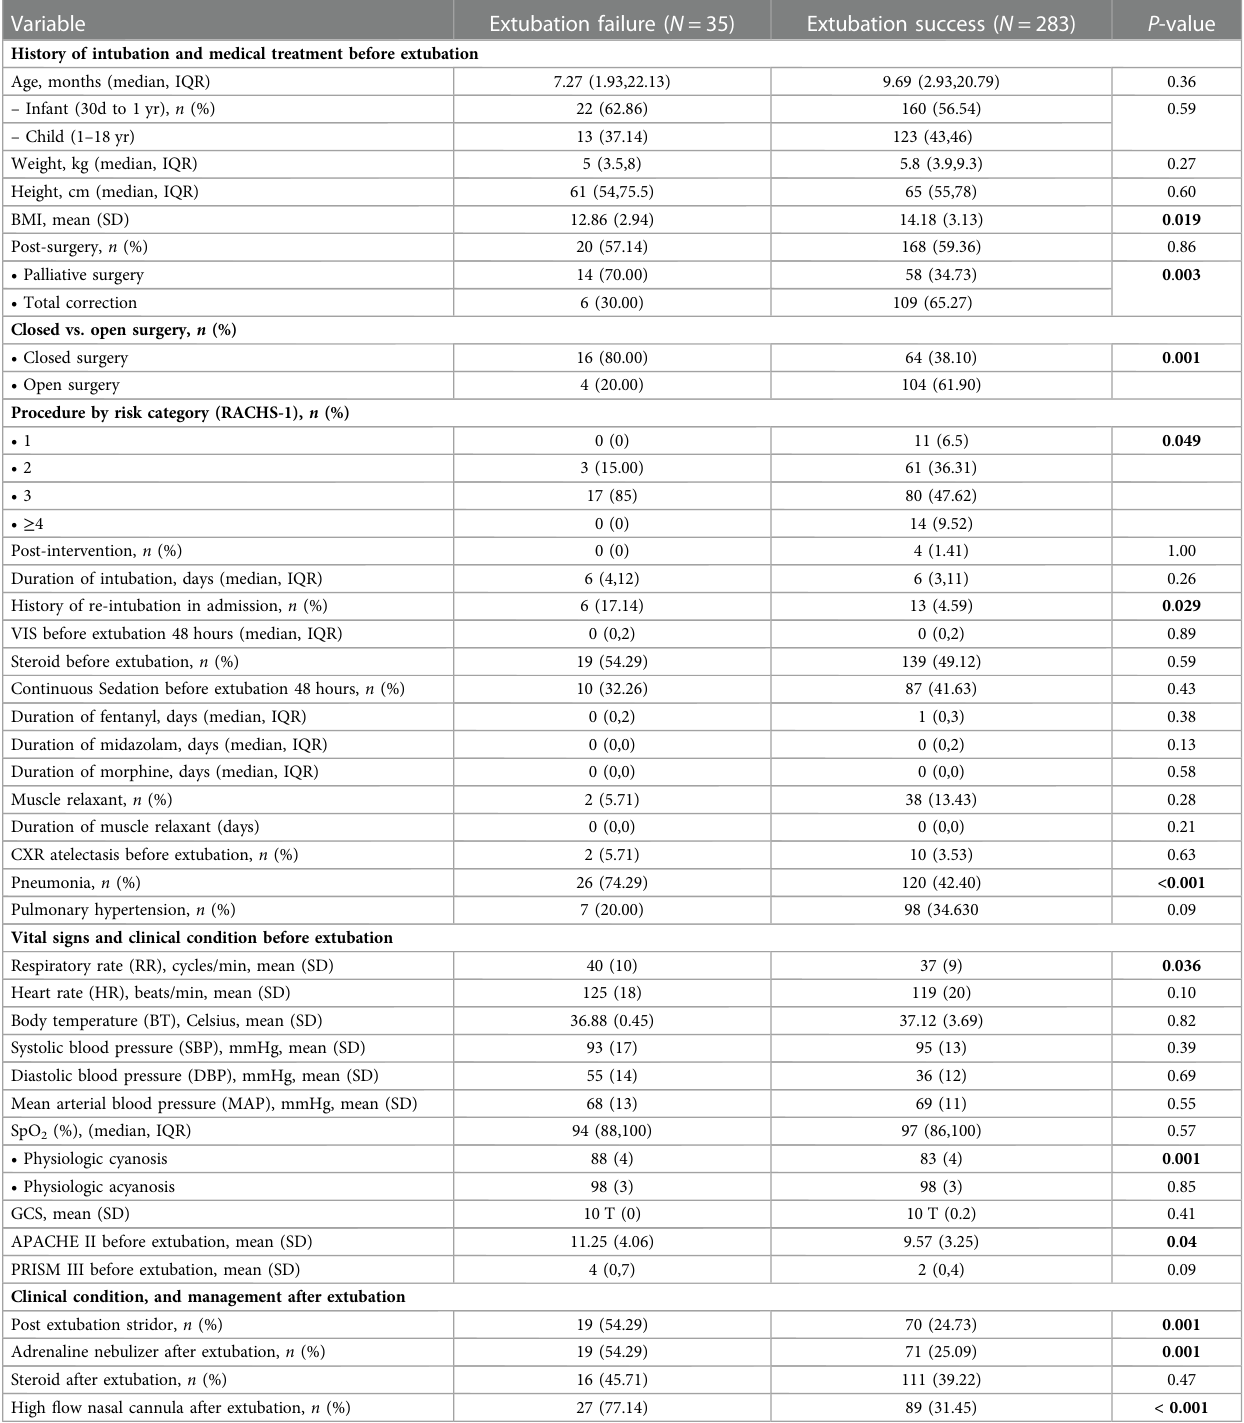
TABLE 2 Comparison of clinical parameters for each included extubation trial between successful and unsuccessful trials.